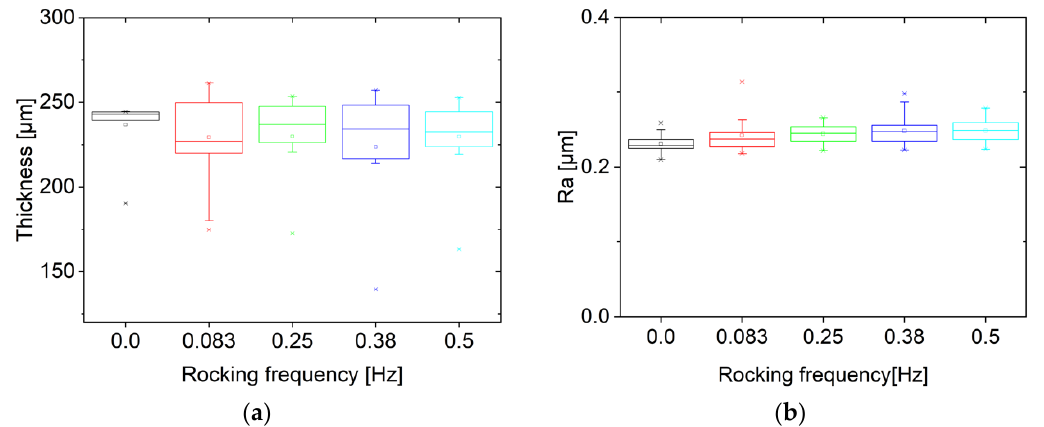
Figure 11. ( a ) Thickness variation for different rocking frequencies; ( b ) roughness values for different rocking frequencies.